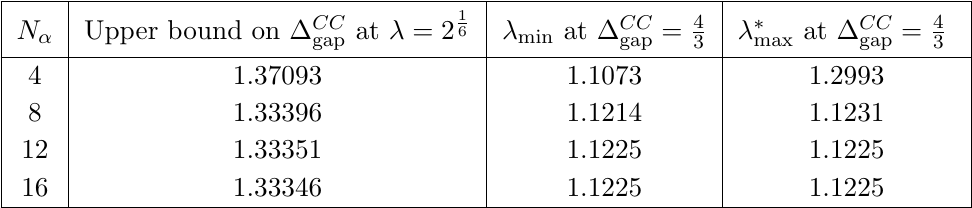
> 2 of the allowed region for (cid:1) CC from the gap gap 3 . (cid:21) (cid:3) is de(cid:12)ned as the value of max 3 for (cid:21) > 2 1 6 are nonzero at (cid:12)nite gap